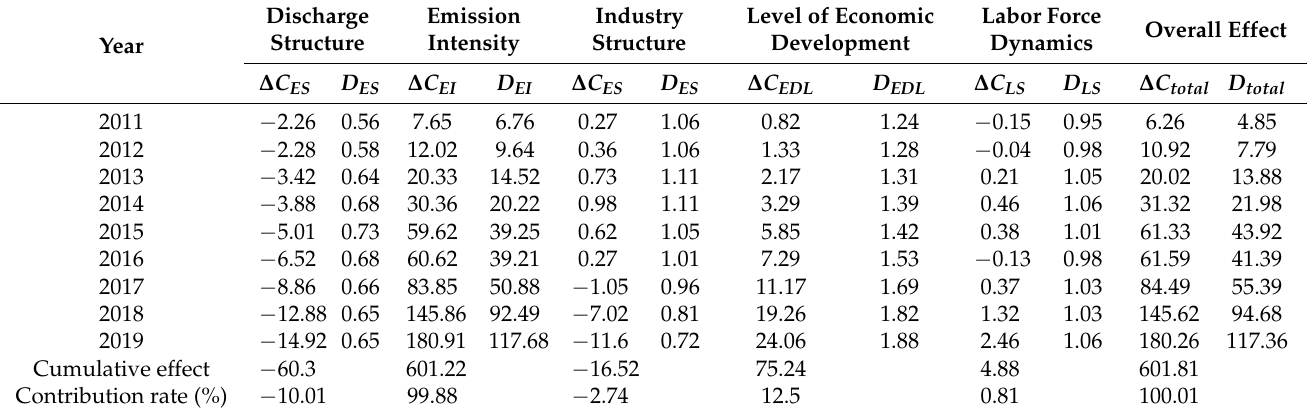
Table 7. Decomposition results of chemical industry carbon emission